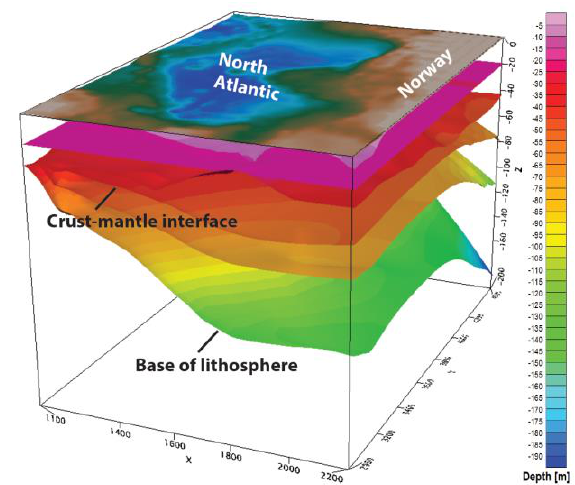
Figure 5: Model in GM-SYS 3D. Displayed are the depth horizons where density contrasts occur.